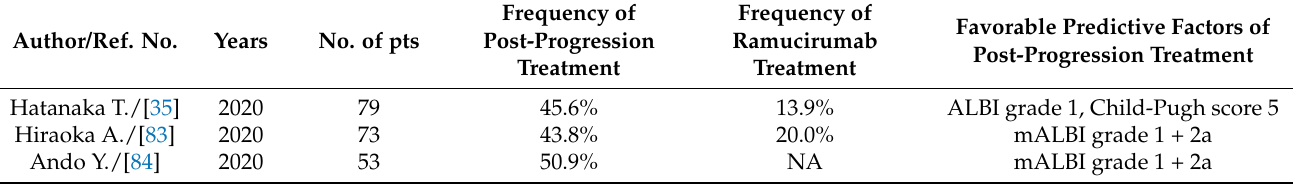
Table 3. Previous studies concerning the candidate for post-progression treatment and ramucirumab treatment.